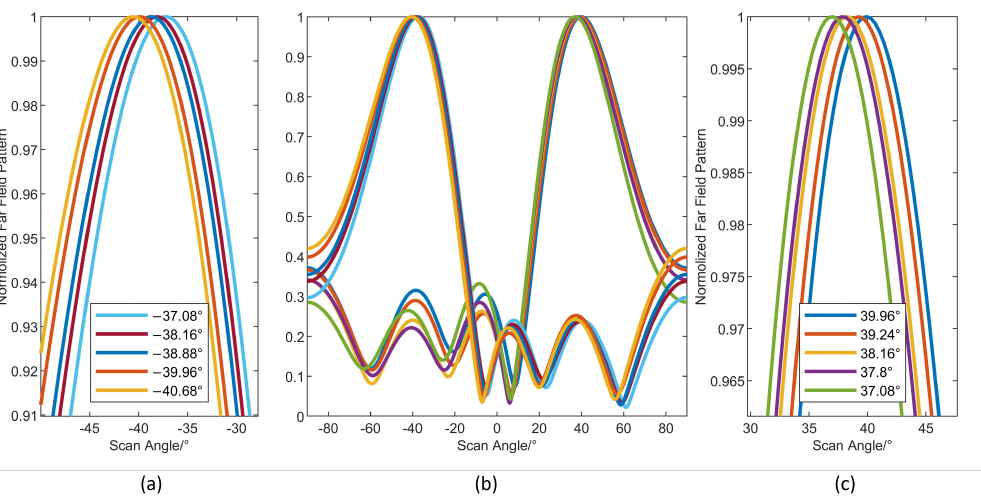
Figure 11. Far-field pattern of small angle steering.